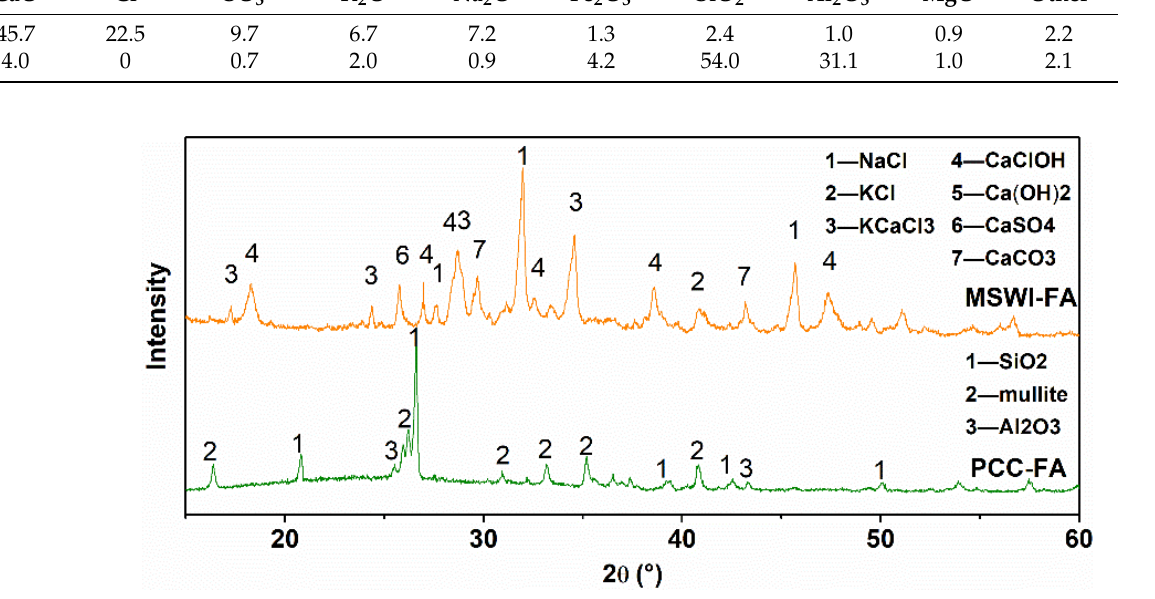
Figure 2. XRD patterns of MSWI fly ash and pulverized coal combustion fly ash.